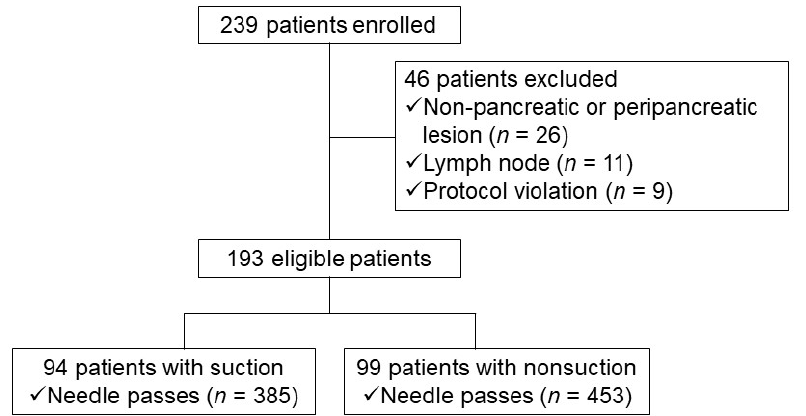
Figure 1. Study flow chart depicting patient selection (study I).